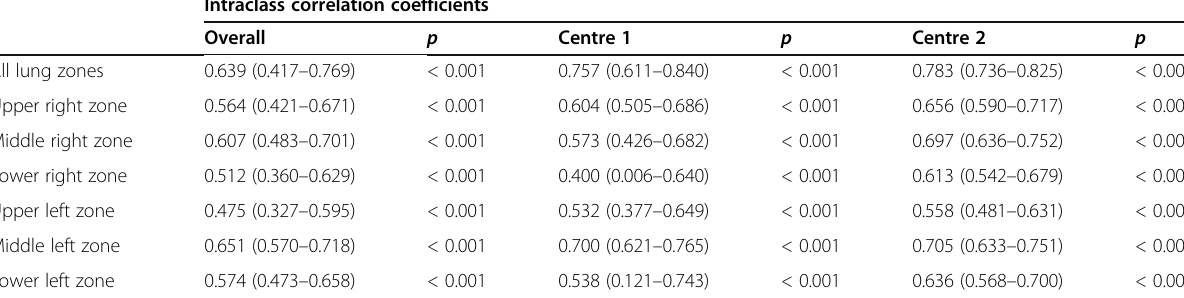
Table 4 Intraclass correlation coefficients in the overall and zone-specific lung evaluation Intraclass correlation